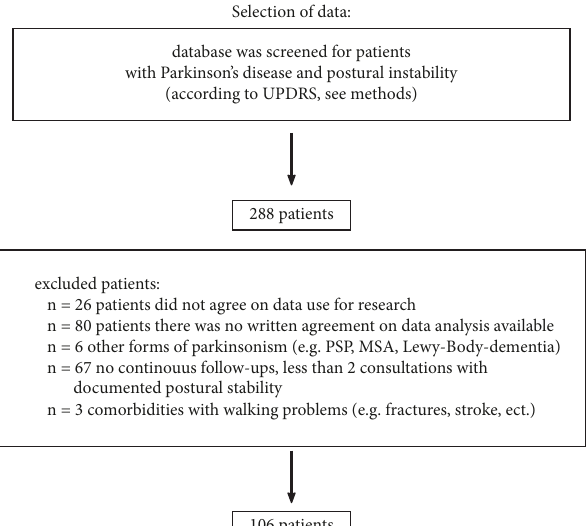
Figure 1: Criteria for patient selection. Patient database was screened for patients with Parkinson’s disease who developed postural stability. 288 patients were found. After excluding the patients according to the exclusion criteria, 106 patients were left. UPDRS: Unifed Parkinson’s Disease Rating Scale, PSP: progressive supranuclear palsy, and MSA: multiple system